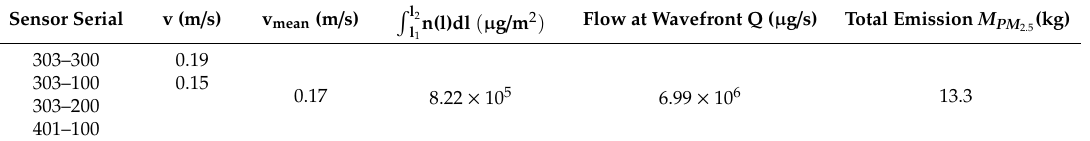
Table A4. PM 2.5 Emission calculation from ground level smoke-wave C.